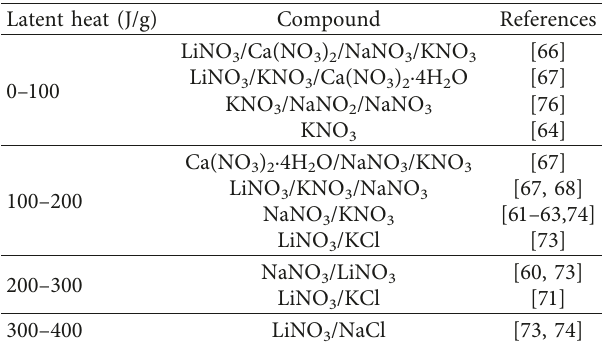
Table 4: The latent heat of medium-temperature inorganic eutectic composites.